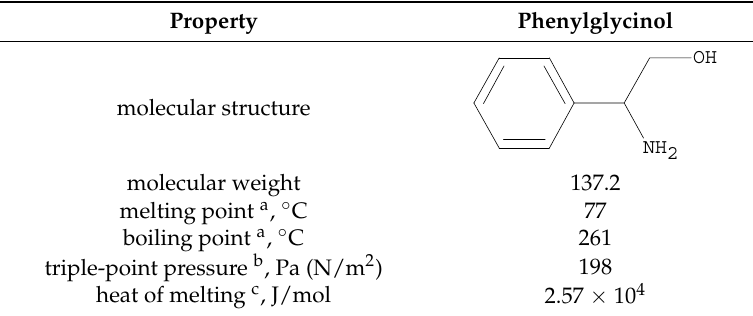
Table 1. Some physical properties for phenylglycinol.